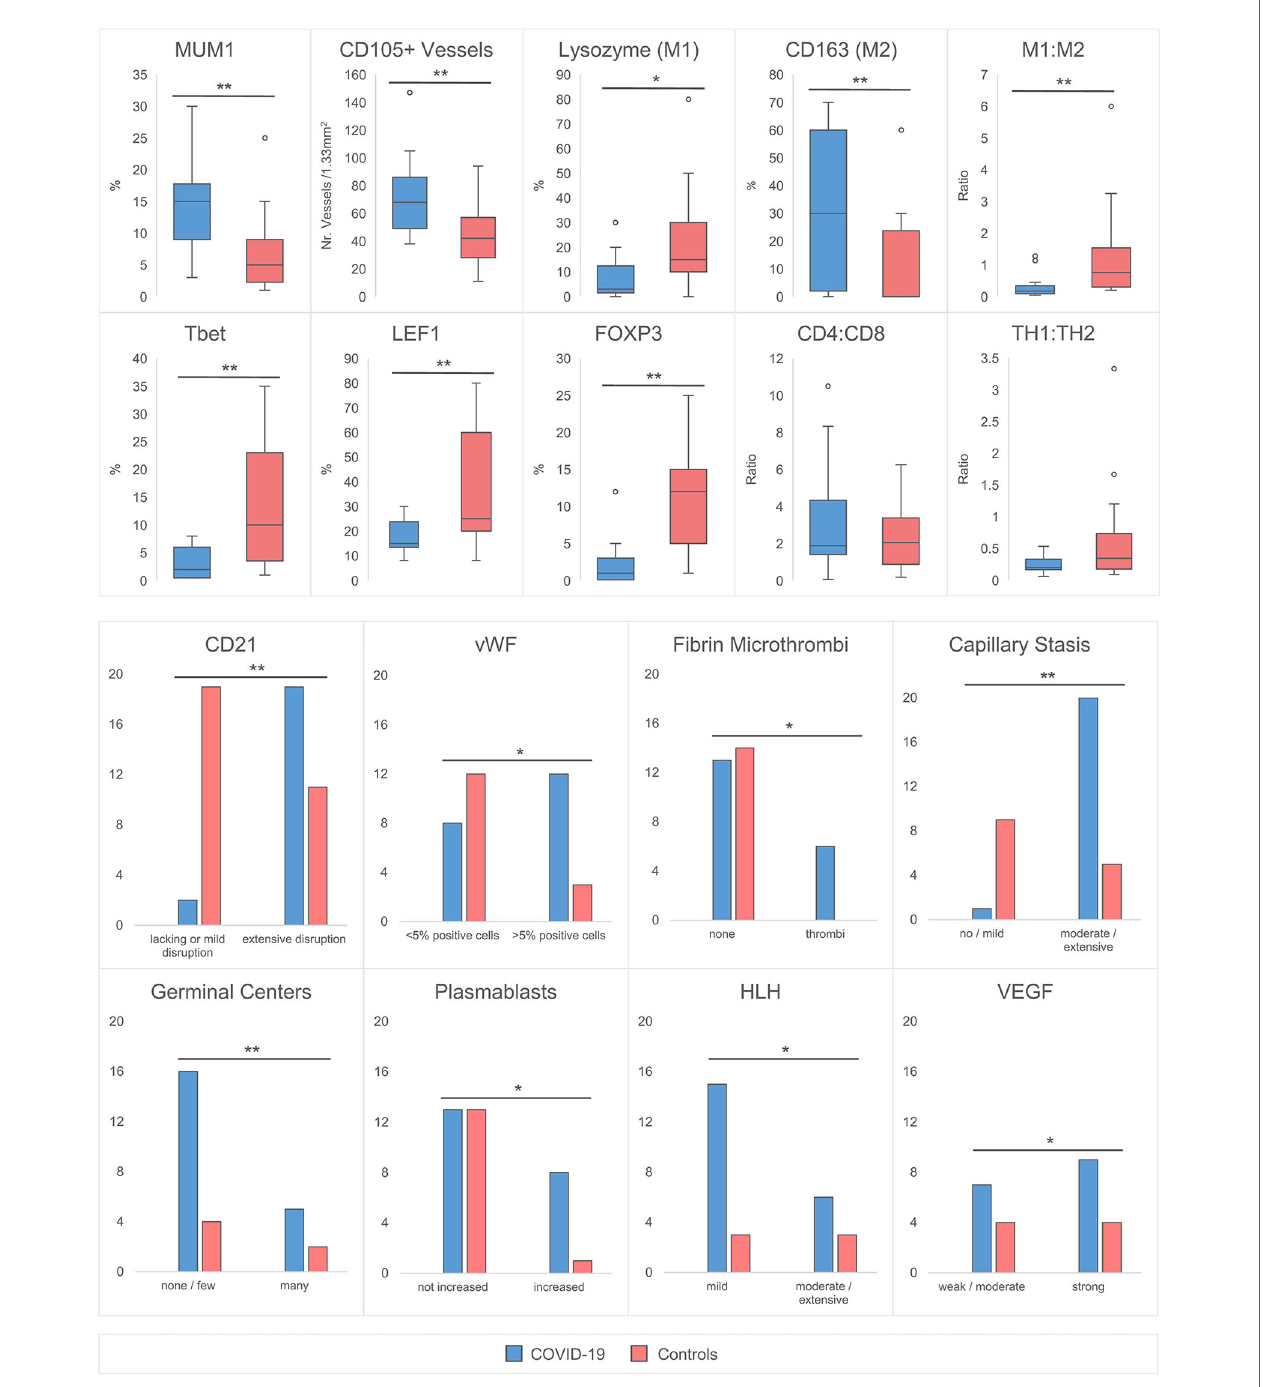
FIGURE 3 | Quantitative Histomorphological and Immunohistochemical Characteristics between COVID-19 Cases and Controls. A signi fi cantly higher % of MUM1+ plasmablasts, CD105+ capillaries and CD163+ macrophages is observed in COVID-19. In contrast, the % of lysozyme positive macrophages, Tbet, LEF1 and FOXP3+ T-cells was decreased. The M1:M2 (lysozyme:CD163) ratio is decreased, while CD4:CD8 and TH1:TH2 (Tbet : GATA3) ratios remain unchanged. An increased incidence of CD21+ FDC network disruption with an accompanied lack of germinal centers, increase of plasmablasts, microthrombosis, stasis/edema and moderate/extensive hemophagocytosis is observed in COVID-19 versus controls. The incidence of >5% vWF positive cells and the expression of VEGF is increased. *signi fi cant at the 0.05 level, ** signi fi cant at the 0.01 level. HLH designates increased hemophagocytic activity of histiocytes, but not hemophagocytic